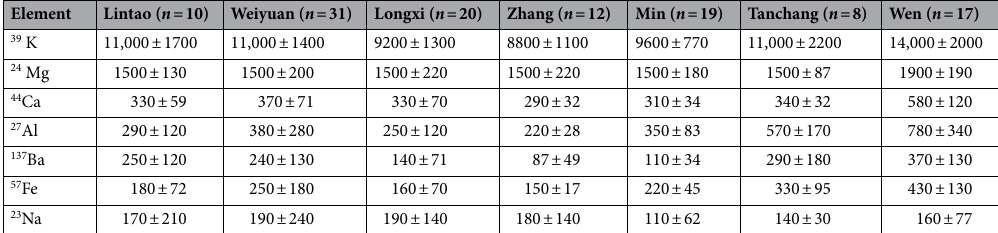
Table 1. Macro elements content of Codonopsis Radix samples according to their geographical origin (Content are expressed as μg/g of dry matter